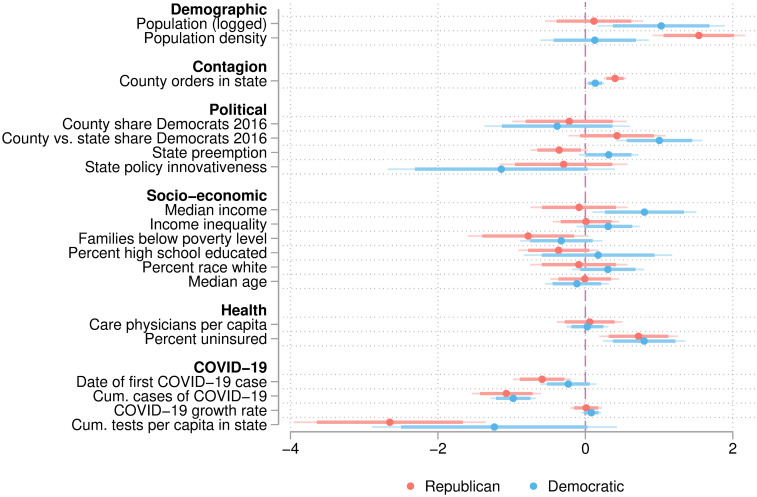
Regression coefficients of split-population Cox models by politics.Predicting presence of a county-wide policy in predominantly Republican (N = 2,653) vs. Democratic (N = 489) counties. The regression by political orientation shows that the effect of political difference to the state is driven by Democratic counties in Republican states (rather than Republican counties in Democratic states). In Republican counties, shelter-in-place orders were associated with functional factors: Greater population density, experiencing COVID-19 sooner, and if state capacity to test was lower. The coefficients of percent of uninsured population indicates that population vulnerability increased a county’s propensity to issue a policy. Main results of political differences between county and state are stronger if TX and PA are excluded, because in both state leadership was involved in ordering shelter-in-place in select counties.